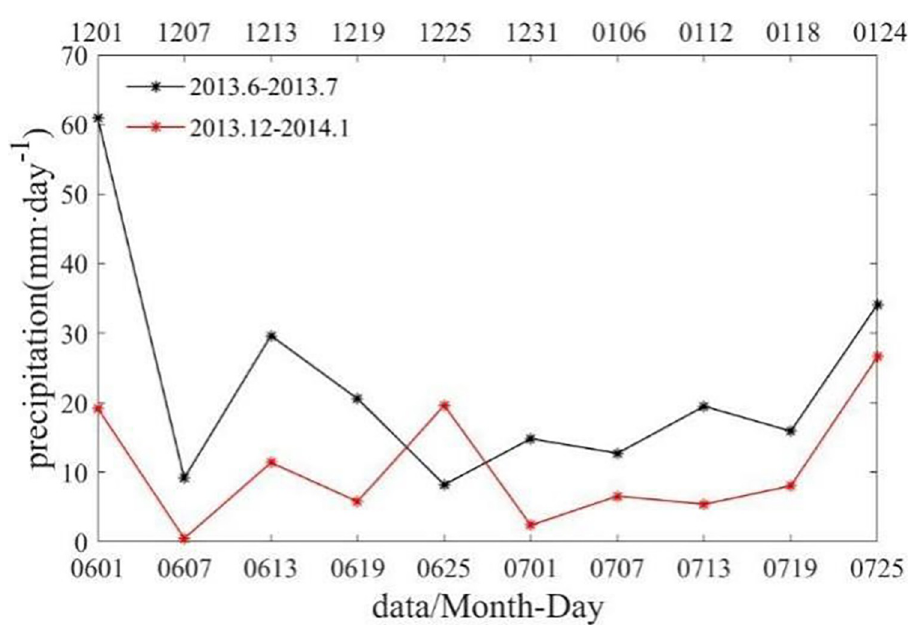
Fig 11. Time series of spatially averaged precipitation in Box B in June and July 2013 (black line), December 2013 and January 2014 (red line).